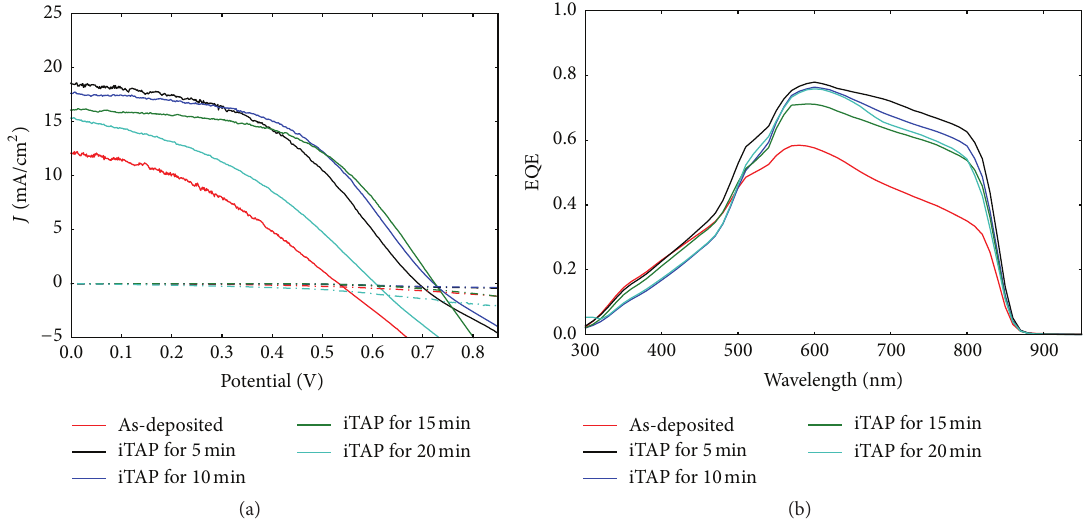
Figure 6: (a) J - V curve characteristics and (b) quantum efficiency curves of thin film CdS/CdTe solar cells with various iTAP durations of 0–20